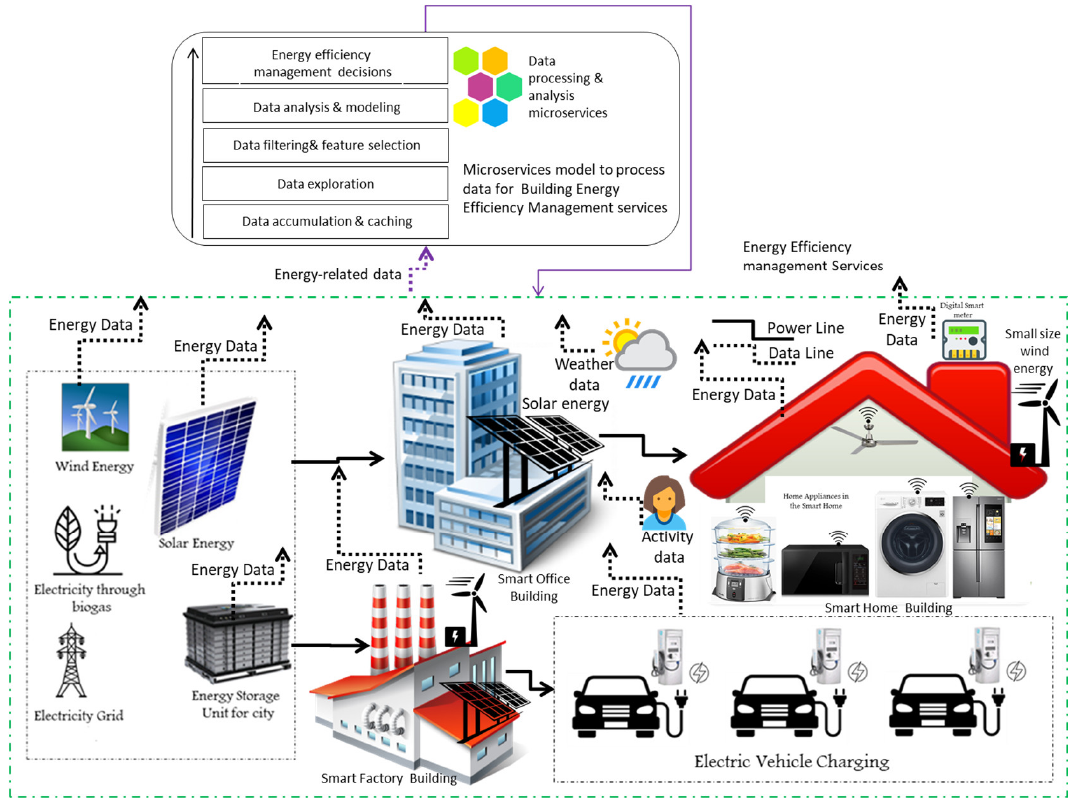
Figure 8. An illustration of use case scenario shows a variety of energy-related data which needs to be enhanced for buildings energy efficiency management services.